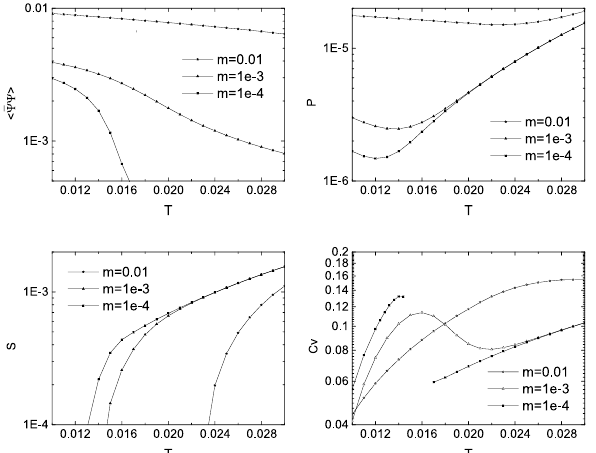
Fig. 7 The values of thermal parameters with different volume while m = 10 − 4